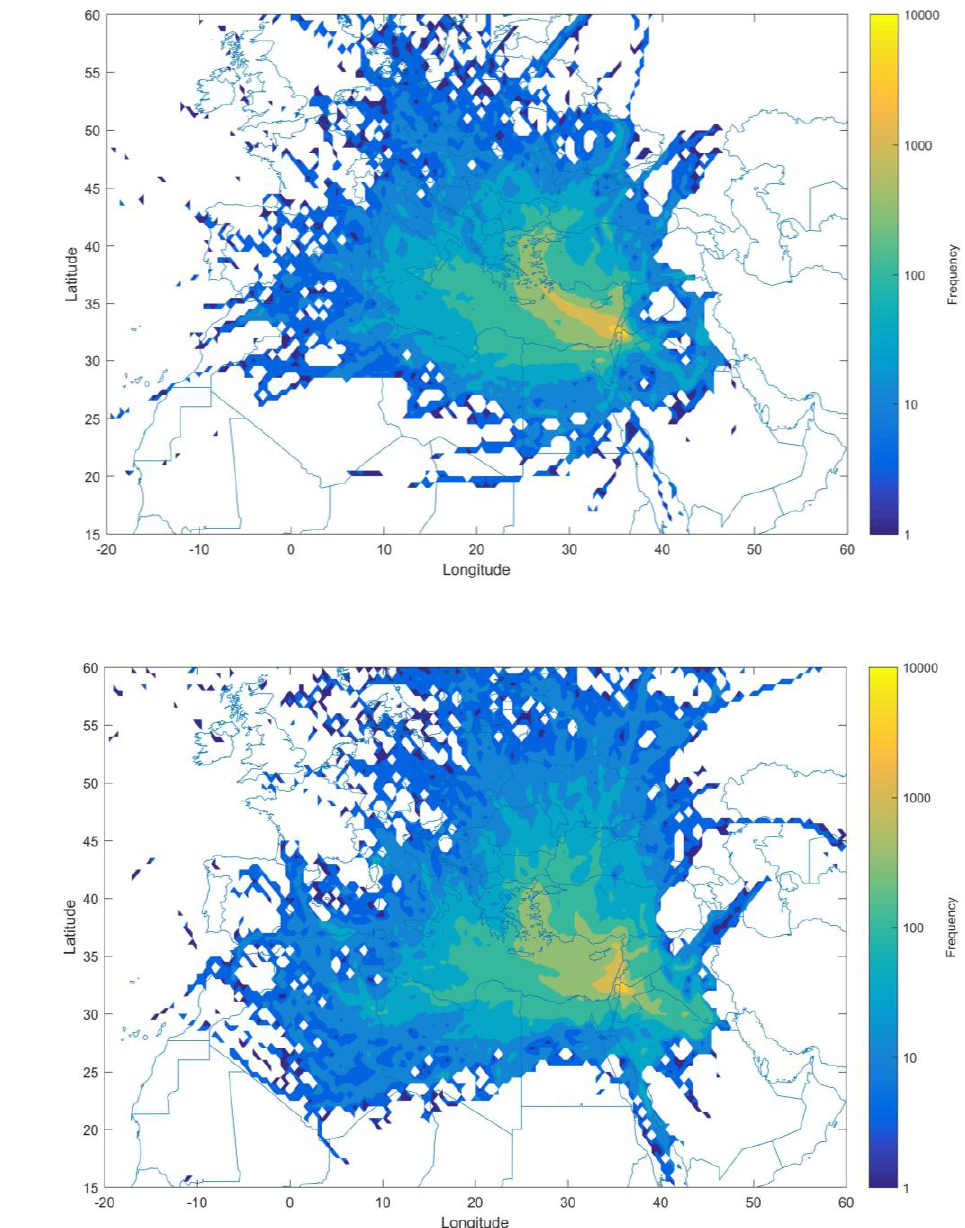
Figure 4. Back trajectories (96 h backward) crossing map during ( a ) new particle formation (NPF) events and ( b ) no-events days. The back trajectories were calculated for each hour at arrival height 100 m in Amman (measurement location). The color contour represents the back trajectories crossing frequency in each grid cell (resolution 0.5 ◦ ).